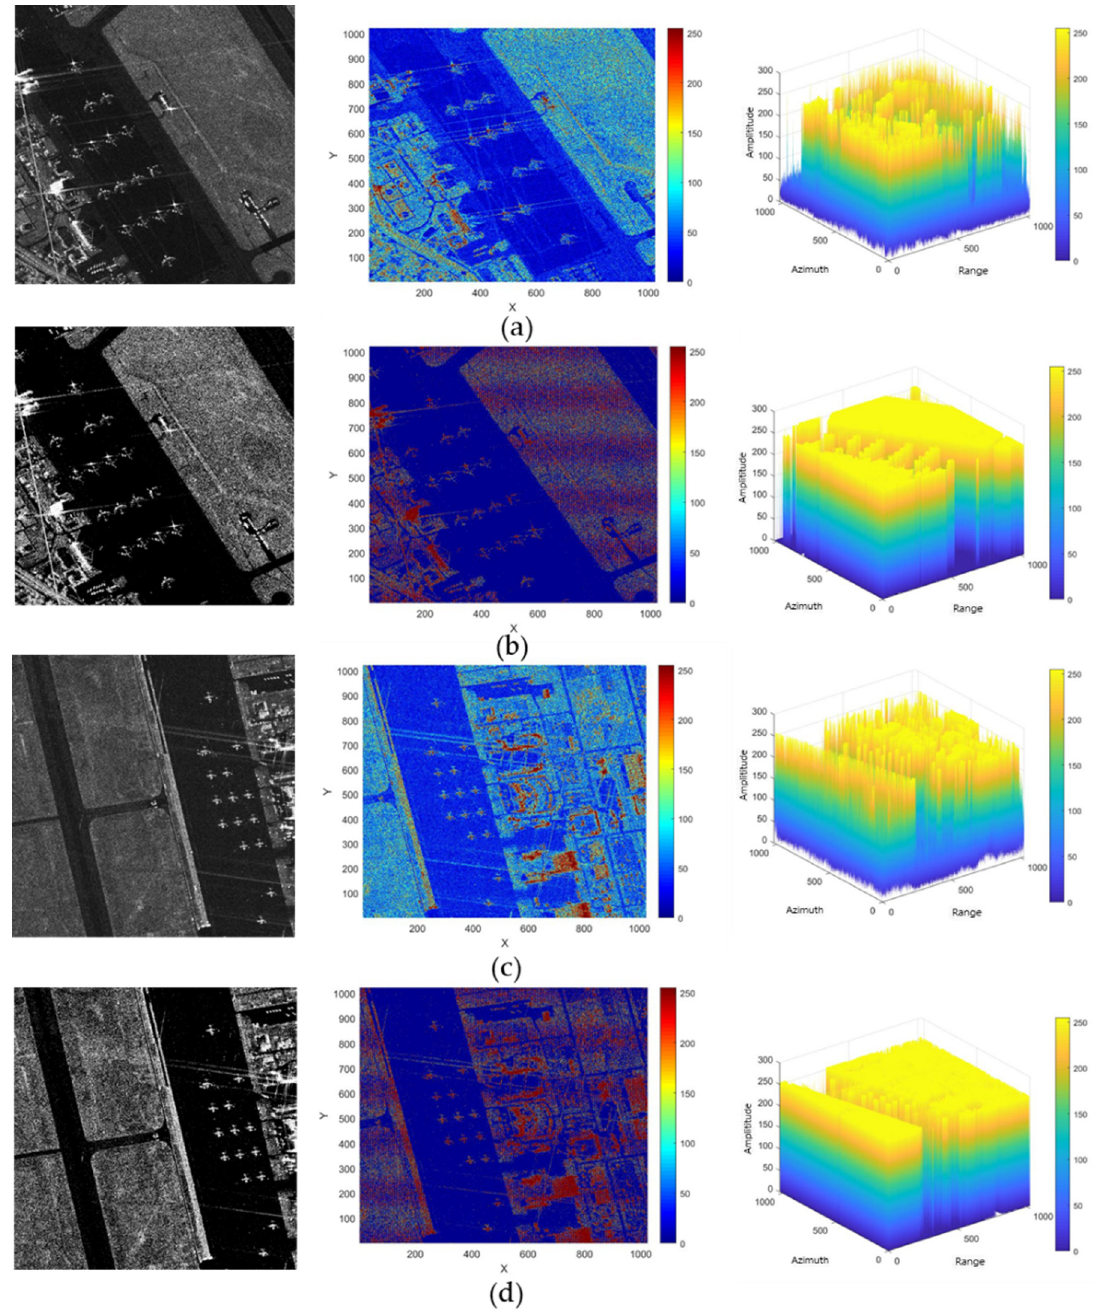
Figure 4. Peak feature extraction and enhancement of SAR images. ( a , c ) The three views, from left to right, are the original SAR images, the 2-D illustration of the SAR image, and the 3-D illustration of the SAR image. ( b , d ) Corresponding to ( a , c ), the three views, the image processed by PFE, 2-D illustration of SAR image, and 3-D illustration of SAR